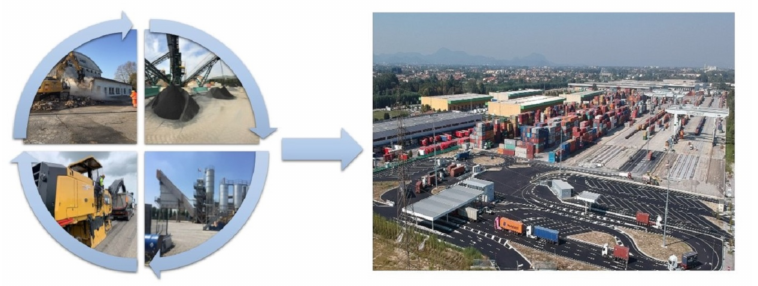
Figure 1. Material recovery cycle from construction and demolition materials (CDM) for the new Terminal of the Padua